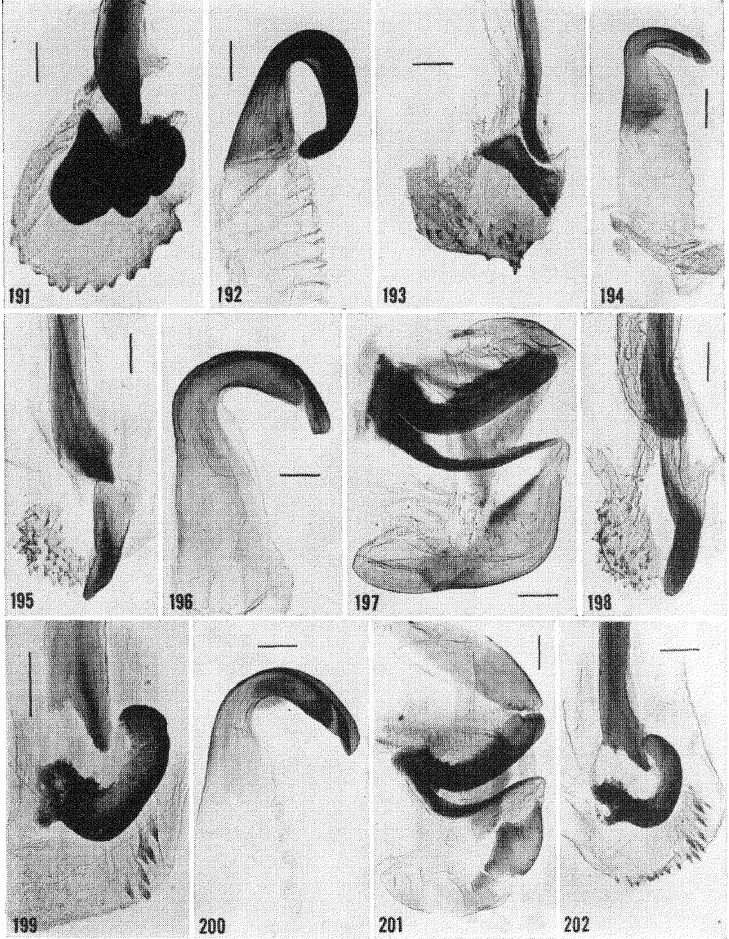
Figs. 191-202. 191-192. (1 ANSP). (from specimen shown in Fig. 163). 193. (5 ANSP). Brachycola sexnotata. (from specimen shown in Fig. 168). 194. (20 MCZ). Brachycola sexnotata. 195-197. (1 LEM). Sibylloblatta tanesthoides. England (adventive) (det. McE. Kevan). 198. (5 MCZ). 8ibylloblatta [anesthoides. (from specimen shown in Fig. 169). 199-201. (961 L). Parahormetica b;,lobata, (from specimen shown in Fig. 170). 202. (3 ANSP). Parahormetica bilobata. (from specimen shown in Fig. 171). (scale 0.3